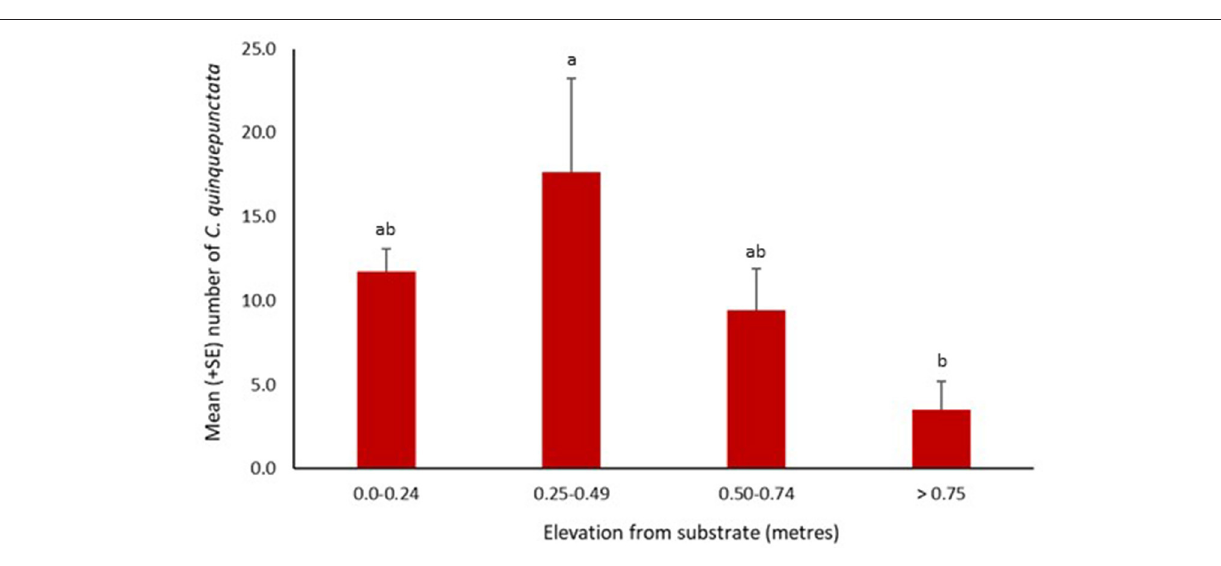
Frontiers in Conservation Science |